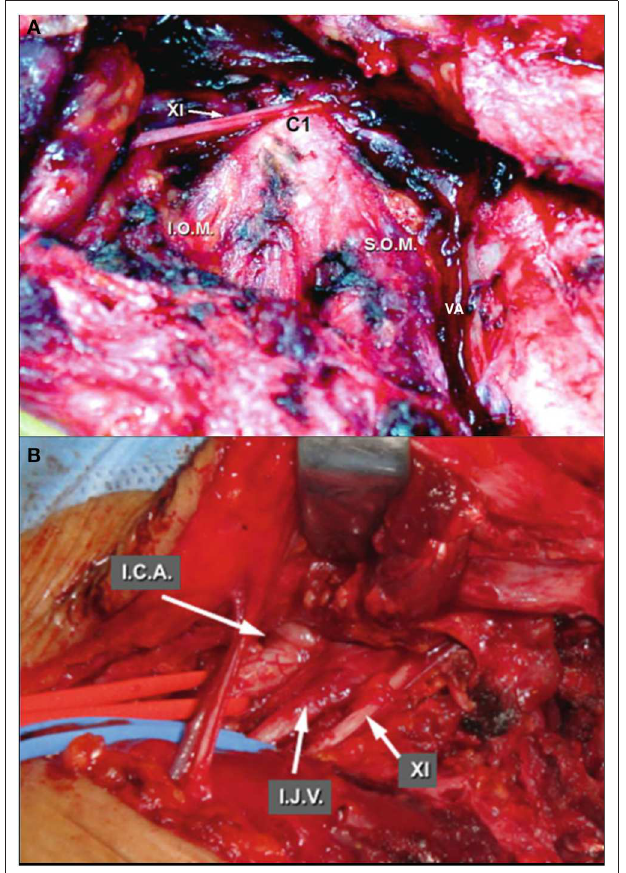
FIGURE 12 | Neck dissection [Modified from Ramina and Tatagiba (3)]. (A) Left lateral mass of C1 as landmark to identify the accessory nerve and vertebral artery. (B) Deeper dissection, identifying the internal carotid artery, internal jugular vein and accessory nerve. ICA, internal carotid artery; IJV, internal jugular vein; IOM, inferior oblique muscle; SOM, superior oblique muscle; VA, vertebral artery; XI, accessory nerve.